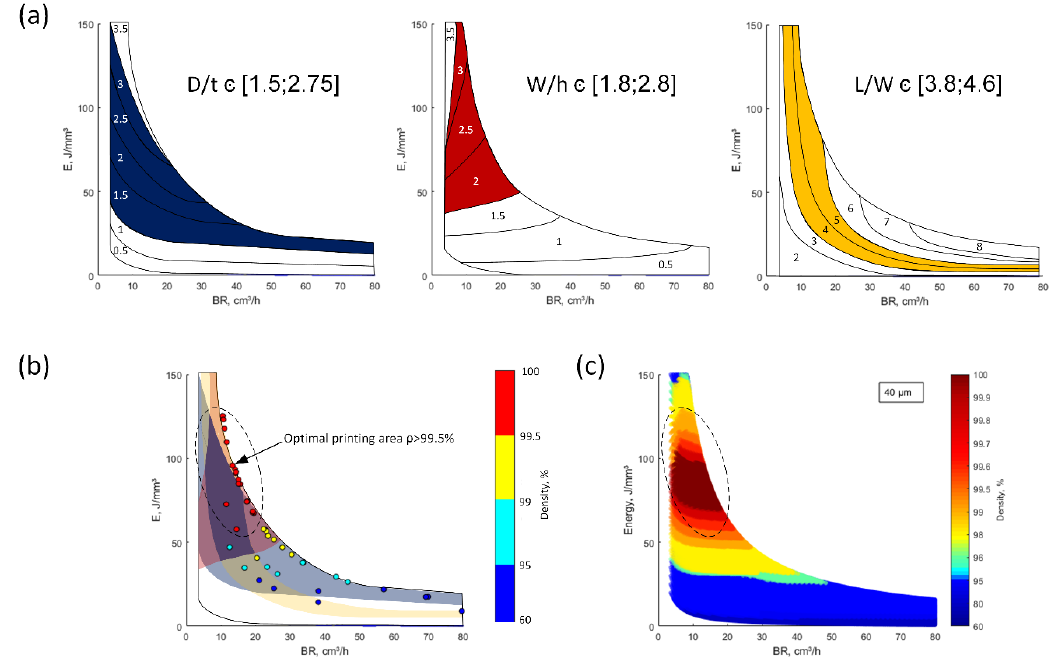
Figure 4. ( a ) Optimal areas for the D/t , W/h , and L/W ratios; ( b ) superposition of the numerically optimized processing window; ( c ) experimentally calibrated processing map